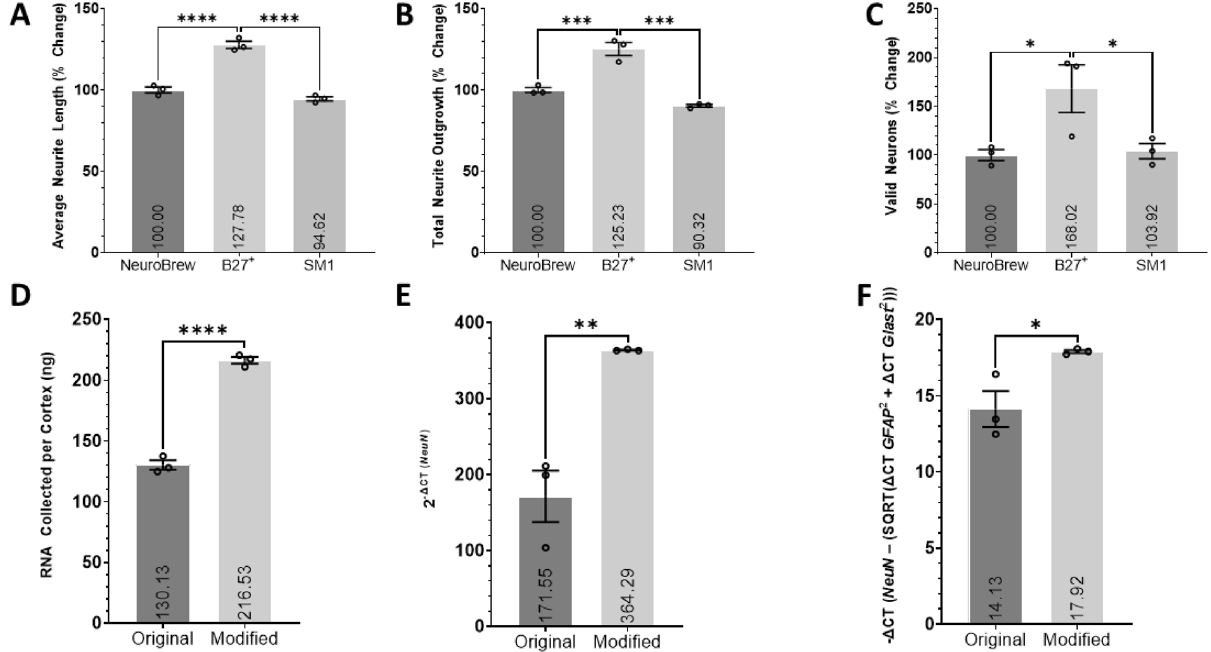
Figure 4. The efficacy of various neuronal supplements and culture purity assessed with RNA expression analysis. Histograms of the ( A ) average neurite length, ( B ) total neurite outgrowth, and ( C ) number of valid neurons of primary cortical neurons treated with the respective neuronal supplement isolated from young adult male mice and cultured for 2DIV. Data is expressed as percent change relative to the B27 + supplement cohort. Data analyzed using one-way ANOVA with Dunnett’s post-hoc test comparing the mean of each condition to the mean of the B27 + supplement group. 3 wells per condition. Histograms of the ( D ) mass of RNA collected from each preparation, ( E ) the relative expression of NeuN expressed as 2 −ΔCT ( NeuN ) and ( F ) the relative expression of NeuN in relation to GFAP and Glast comparing the original protocol from Miltenyi (Original) and our finalized modified protocol (Modified). − ΔCT = − (ΔCT NeuN − (SQRT(ΔCT GFAP 2 + ΔCT Glast 2 ))). All ΔCT values are calculated as follows: ΔCT Primer = CT Primer (Sample) − CT Primer (Negative Control). Student’s T-test was used to compare the means of each cohort. RNA extracted from primary cortical neurons isolated from young adult male mice following the original and modified protocol. 3 independent samples per cohort, each analyzed in triplicate (n = 3). *(P < 0.05), **(P < 0.01), ***(P < 0.001), ****(P < 0.0001). Graphs show mean and